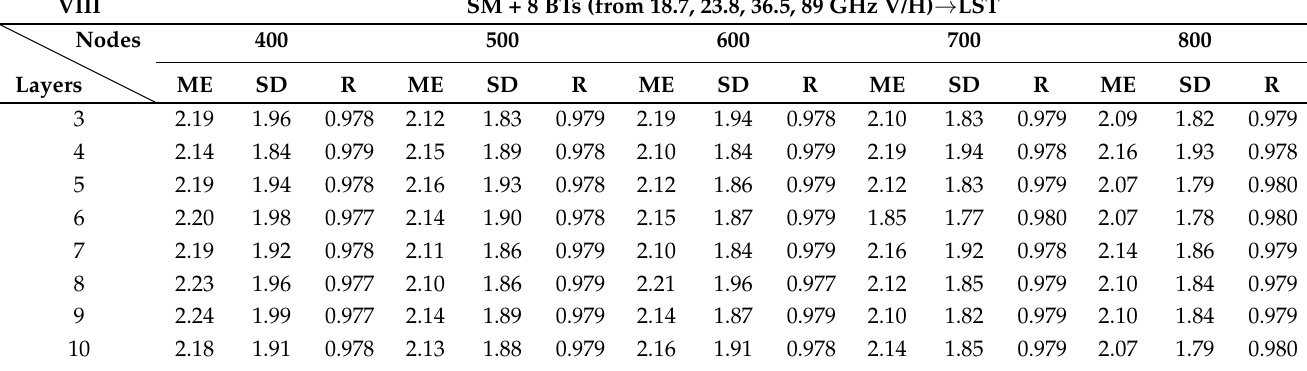
Table 8. SM and eight channels are used to retrieve LST (SM and brightness temperature combination of eight channels).